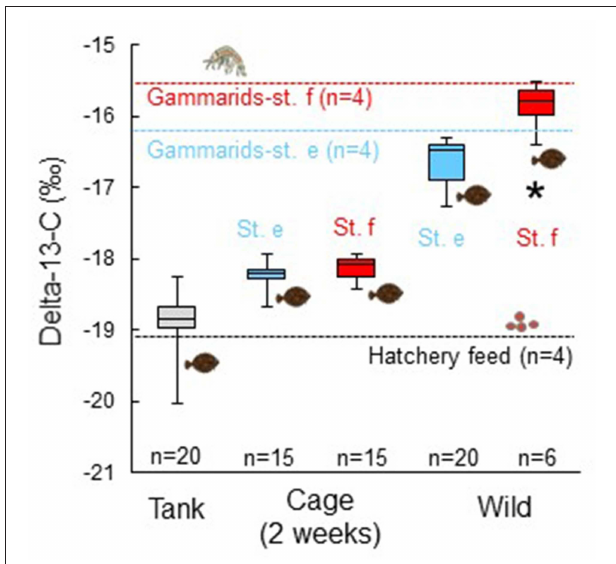
FIGURE 5 | Stable carbon isotope ratio of muscle of juvenile marbled sole sampled from the rearing tank before the experiment (Tank), after the cage experiment for 2 weeks (Cage), and wild marbled sole collected at sts. e and f (Wild). Vertical bars and boxes indicate every 25% range of the data. Mean values for gammarids as major prey organisms for the juvenile marbled sole at sts. e and f and hatchery feed for the juveniles are shown as broken lines. Asterisk shows a significant difference in the isotope ratio of wild fishes between sts. e and f ( p =